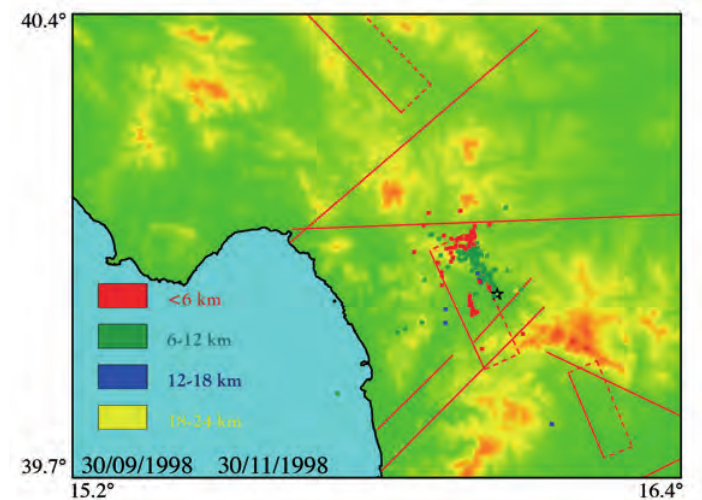
Fig. 9. Event locations in the time interval 30/09/1998-30/11/1998.